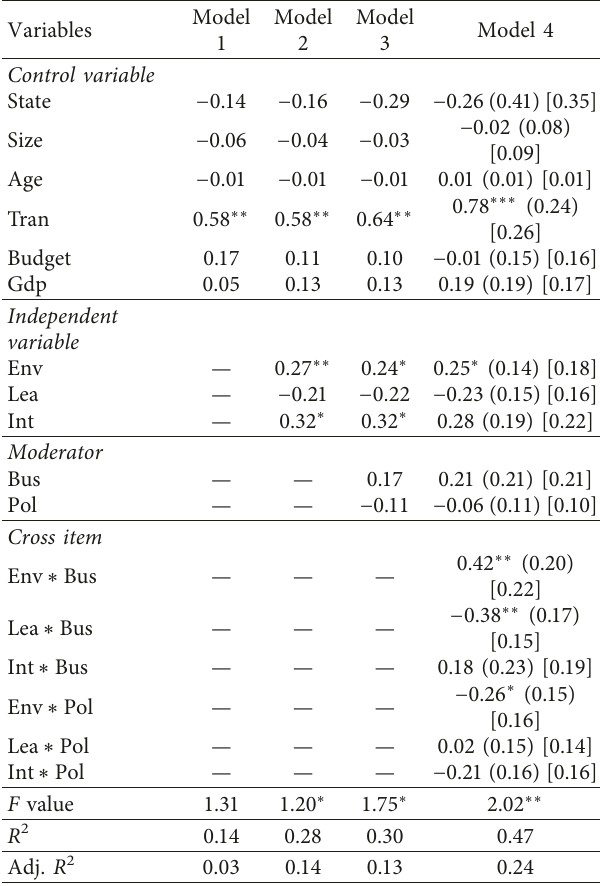
Table 4: Hierarchical regression